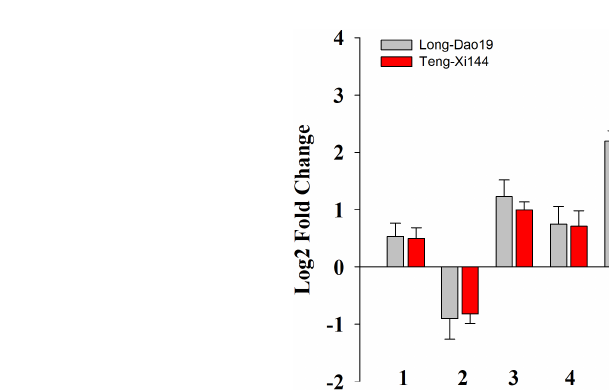
measured the SNC, SKC, RNC, and RKC. The results showed that the SNC and SKC in osbbx11 shoots were more than two times higher than in LD19 shoots. In contrast, the values of RNC and RKC in the roots of osbbx11 were low compared with those of LD19 (Figure 6C). Altogether, OsBBX11 has a positive and signi fi cant function in STS.